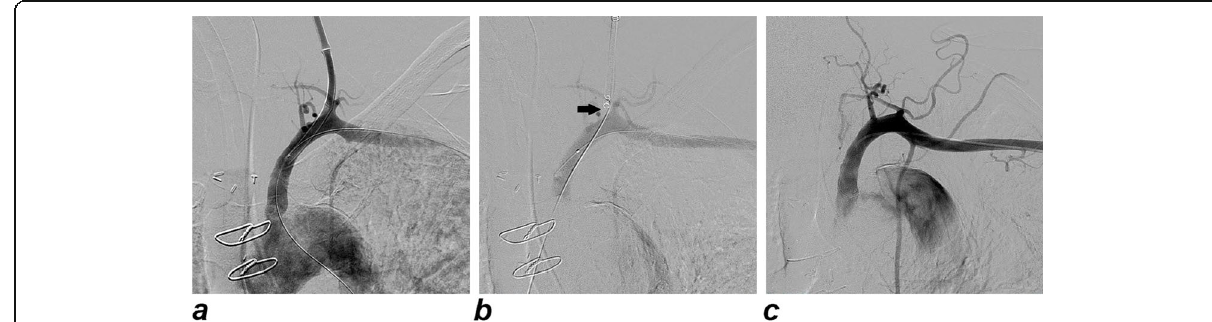
Fig. 1 a Preliminary angiogram demonstrating the access site of the central venous catheter with the entry point located in between the vertebral artery and the thyrocervical trunk. An 8-mm diameter occlusion balloon catheter is placed in the subclavian artery near the entry point of the misplaced central venous catheter. b Angiogram executed after the deployment of the PP and during the tightening of the knot. On the upper side, the slipknot is located close to the arterial wall (arrow). c Final angiogram confirming the absence of active bleeding, stenosis